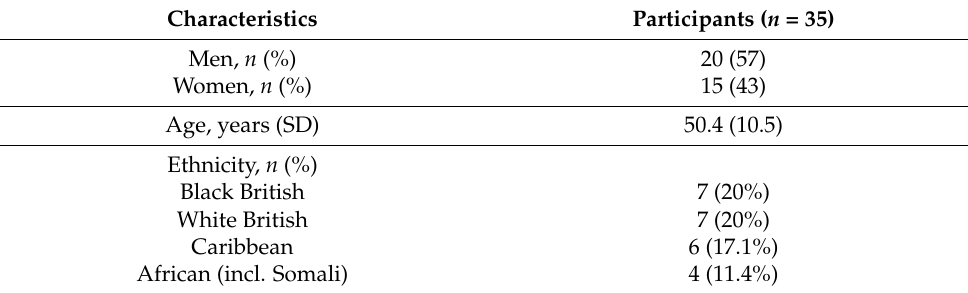
Table 1. Baseline characteristics of